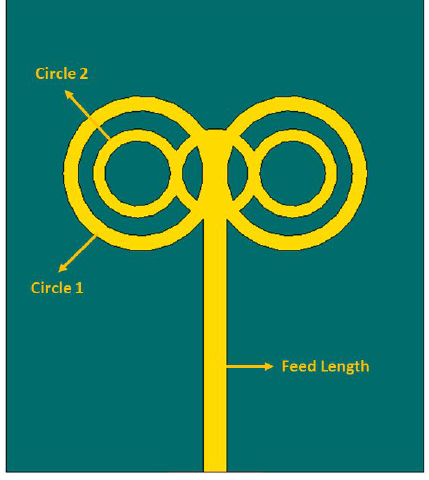
Figure 1. Proposed single-element antenna.